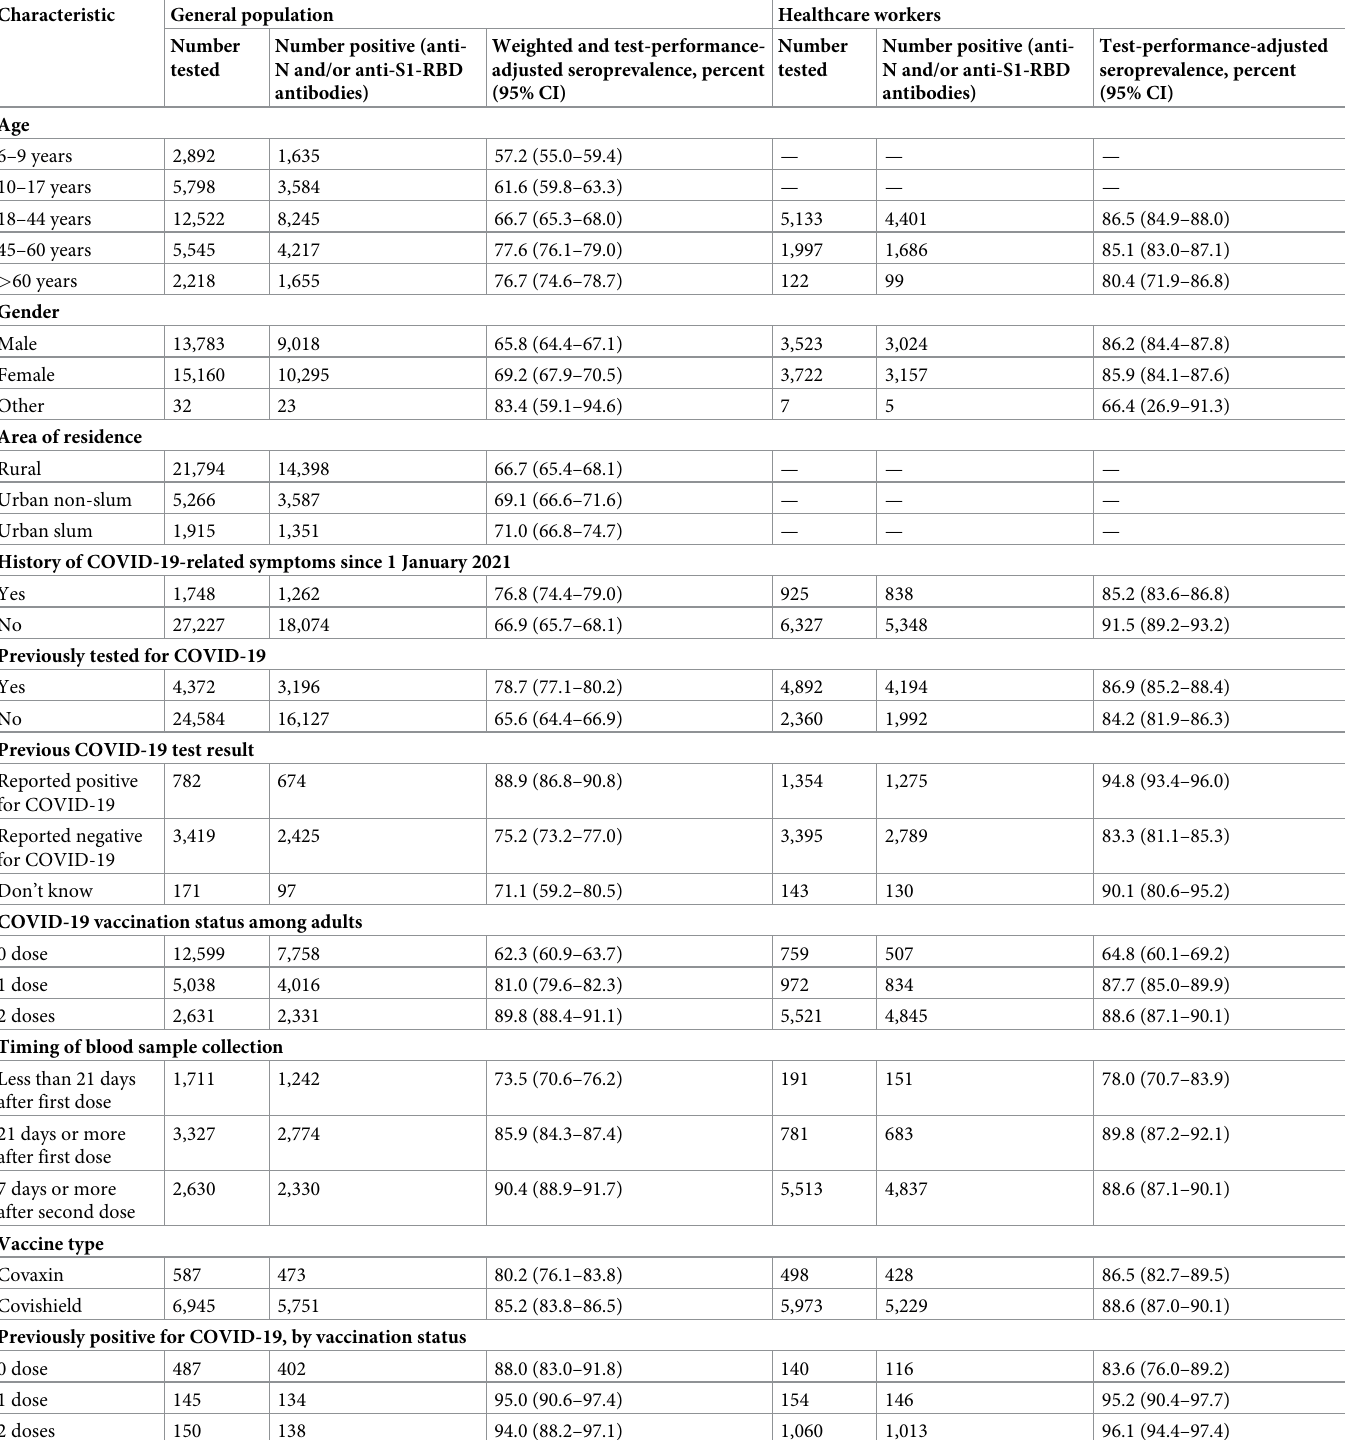
Table 3. Seroprevalence of IgG antibodies against SARS-CoV-2 by selected characteristics, June–July 2021.